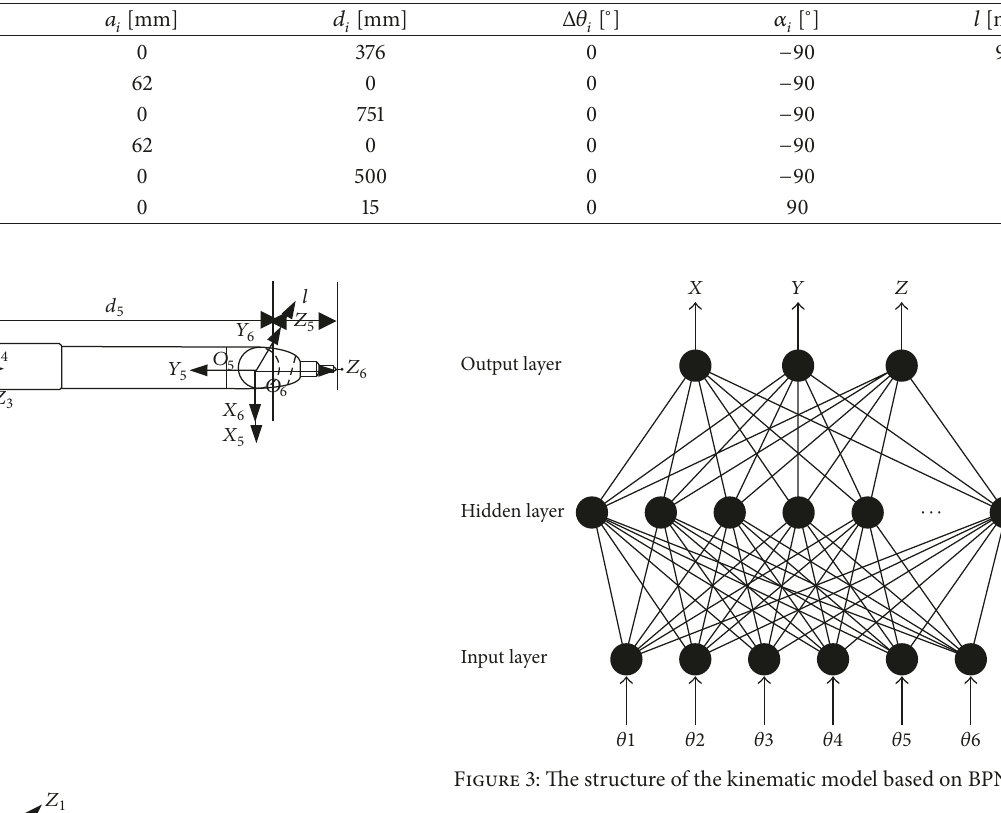
Table 1: The nominal structural parameters of the AACMM.